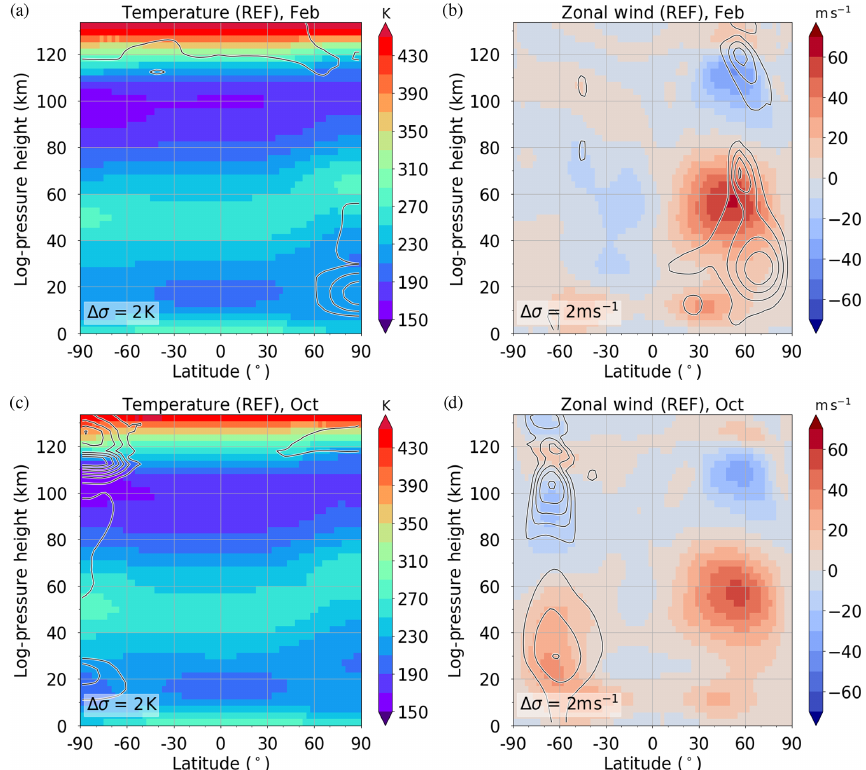
Figure 2. Panels (a) and (c) show the REF zonal mean temperature, and panels (b) and (d) show zonal wind for (a, b) February and (c, d) October conditions. Results are an average of 11 ensemble members (shaded color). Standard deviations σ are 2K for temperature and 2ms − 1 for zonal